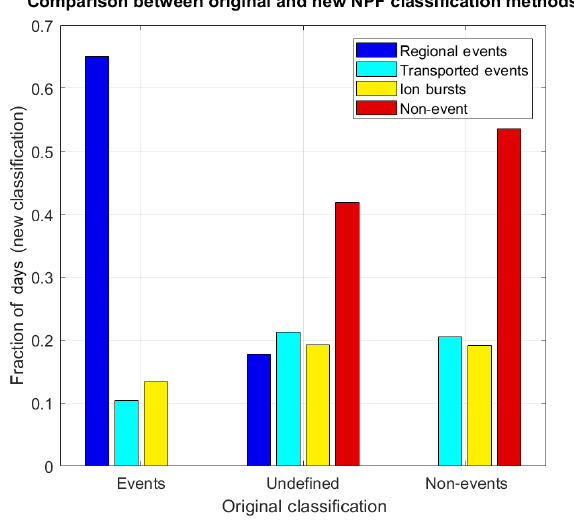
Figure 7. Comparison between original and new NPF classifica- tion methods. The refined classification matches 94% with original event and non-event